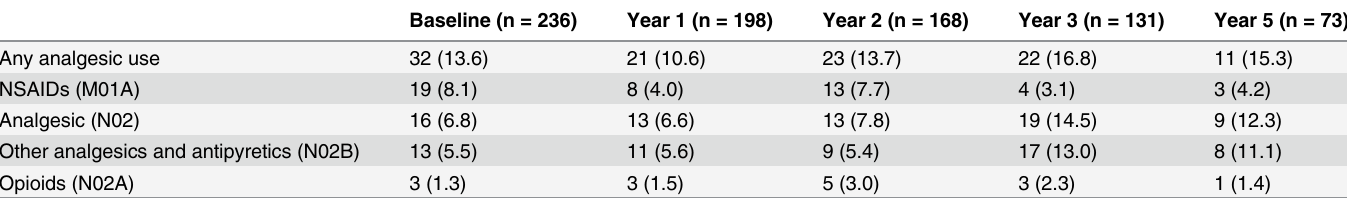
Table 2. Types of analgesics used by persons with Alzheimer ’ s disease, n